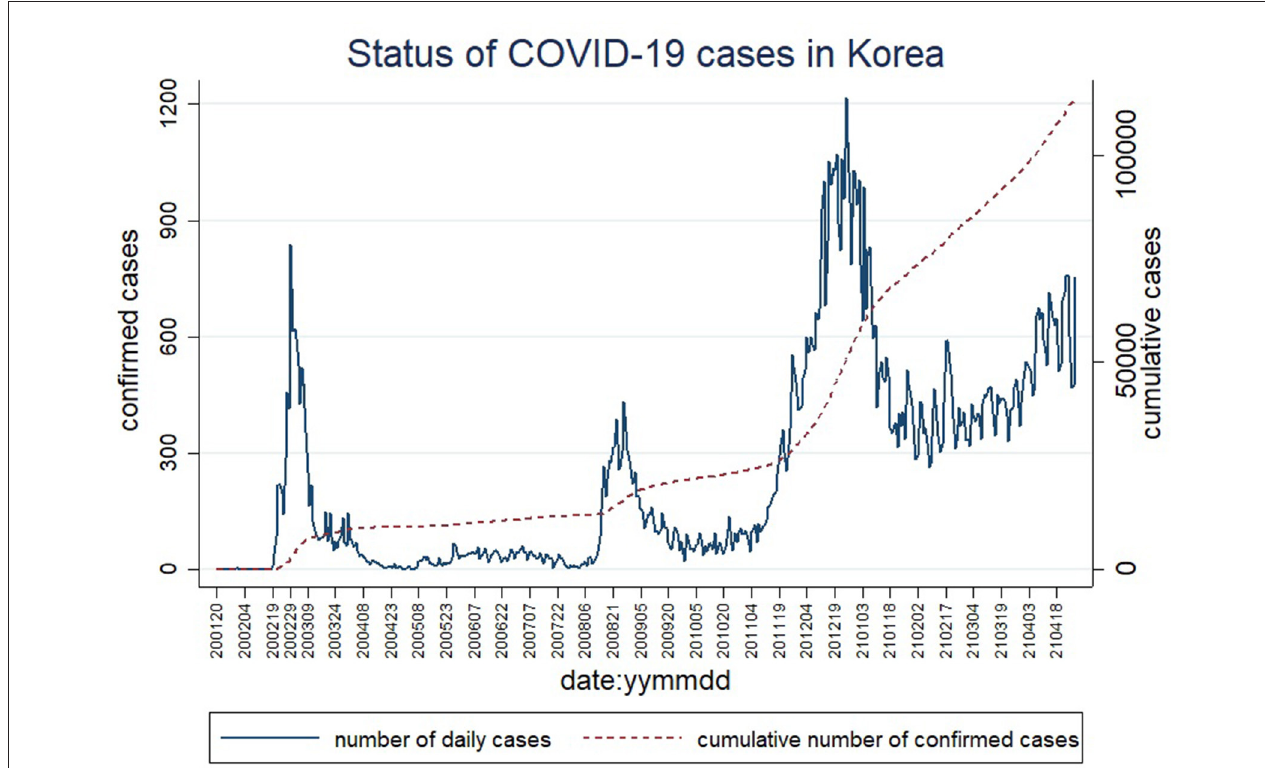
FIGURE 1 | Daily trend and cumulative trend of COVID-19 confirmed cases in South Korea. Both the daily trend and the cumulative trend of COVID-19 confirmed cases use the number of people as a unit. The first two digits of the six digits of the date indicate the year 2020 or 2021. The middle two digits represent January through December. The last two digits represent the date from the 1st to the 31st.